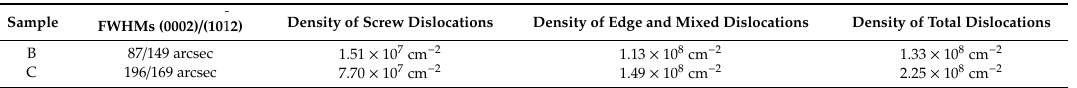
Figure 6. ω -scan rocking curve at the symmetric ( a ) (0002) plane and ( b ) (1012) plane of GaN films on Figure 6. ω-scan rocking curve at the symmetric ( a ) (0002) plane and ( b ) (10 1̅ 2) plane of GaN films on 25 nm and 40 nm sputtered AlON / PSS templates. 25 nm and 40 nm sputtered AlON/PSS templates. Table 1. FWHM results of the ω -scan rocking curve at the symmetric (0002) and (1012) planes, and Table 1. FWHM results of the ω-scan rocking curve at the symmetric (0002) and (10 1̅ 2) planes, and calculated density of calculated density of dislocations.